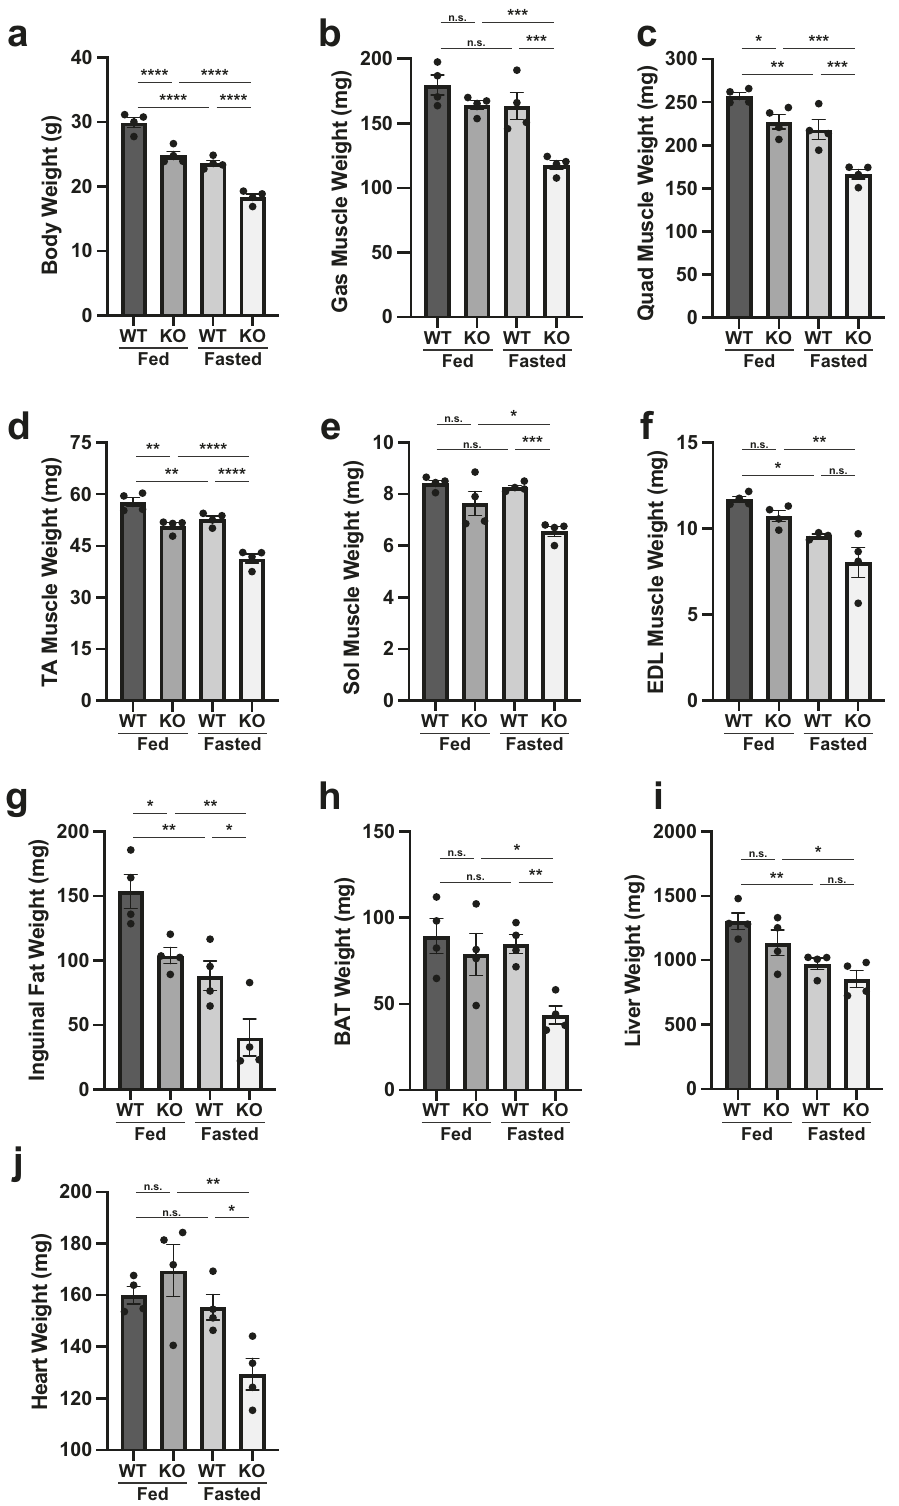
Fig. 3 Loss of Parkin exacerbates the muscle and fat loss upon fasting in mouse model. a Graph showing body weights of wild type (WT) and Parkin KO (KO) as fed and following 48 h fasting ( n = 4). b – f Graphs showing weights of Gas ( b ), Quad ( c ), TA ( d ), Sol ( e ) and EDL ( f ) in fed and fasted wild type (WT) and Parkin KO (KO) mice ( n = 4). g , h Graphs representing the weights of inguinal fat pad tissue ( g ) and brown adipose tissue (BAT) ( h ) following 48 h fasting in wild type (WT) and Parkin KO (KO) mice as compared to fed counterparts ( n = 4). i Graph showing liver weight following 48 h fasting in wild type (WT) and Parkin KO (KO) mice as compared to fed counterparts ( n = 4). j Graph showing heart weight following 48 h fasting in wild type (WT) and Parkin KO (KO) mice as compared to fed counterparts ( n = 4). Data represent mean ± s.e.m. with error bars indicating s.e.m., n.s. not signi fi cant, * P < 0.05, ** P < 0.01, *** P < 0.001, **** P < 0.0001 (ordinary one-way